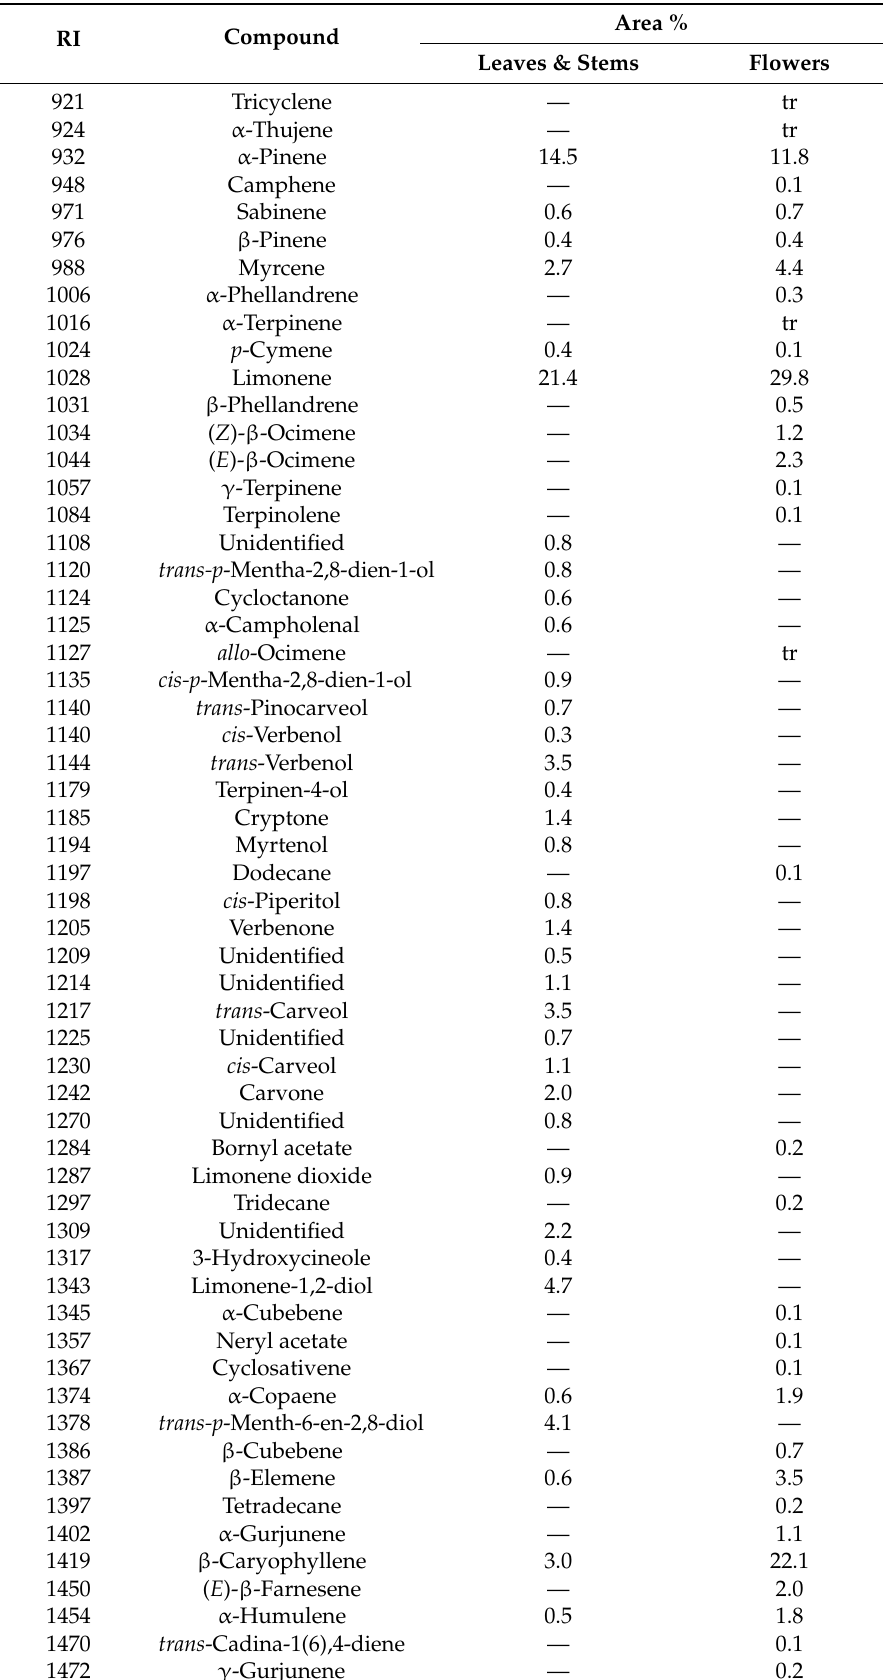
Table 1. Chemical compositions of Erechtites hieraciifolius essential oils from